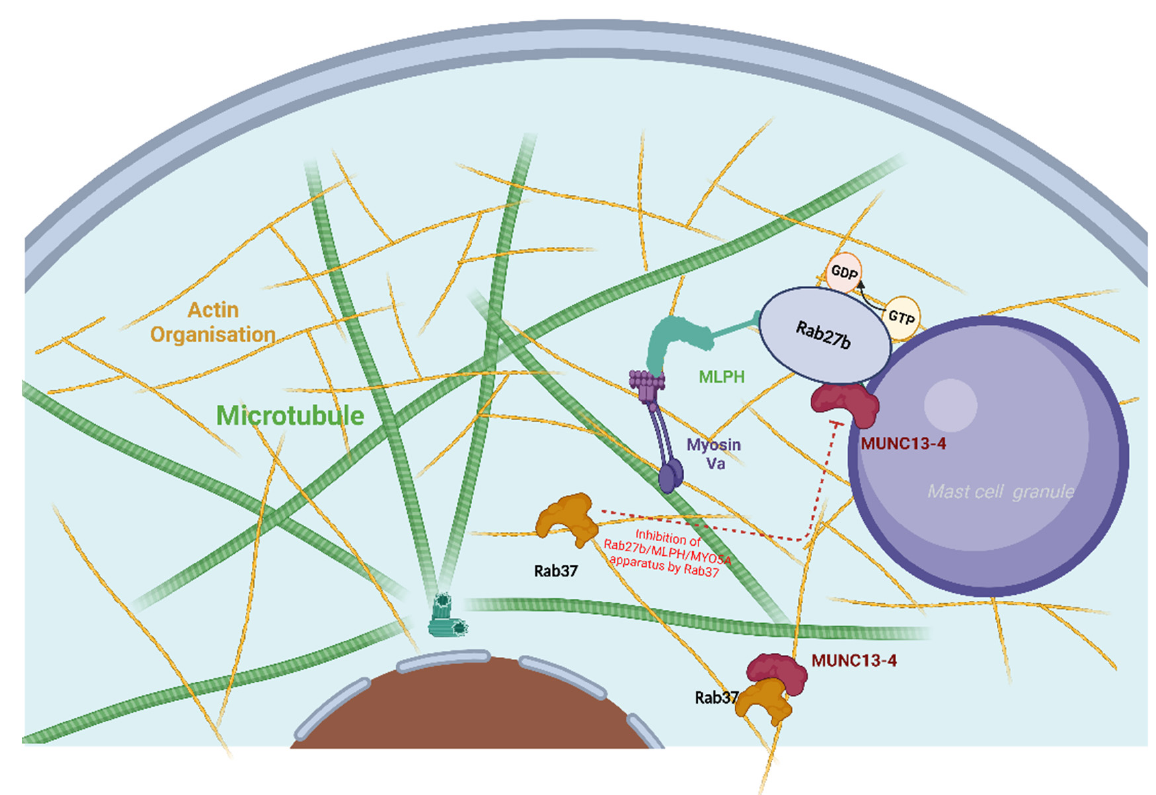
Figure 5. The granule transport machinery of MCs with involvement of melanophilin and Rab proteins. The intracellular transport of cytoplasmic granules to the MC surface for exocytosis requires a complex motor apparatus connected to the granule membrane, in which a motor protein myosin Va and microtubules work together. In this machinery, melanophilin (MLPH) directly connects myosin Va with Rab proteins located on the granule membrane. Subsequent docking to the plasma membrane is carried out by the protein unc-13 homolog D, which in turn can be blocked by RAB37. See main text for further details. Abbreviations: MLPH (melanophilin), MUNC13-4 (Protein unc-13 homolog D), RAB27A (Ras-related protein Rab-27A), RAB27B (Ras-related protein Rab-27B), and RAB37 (Ras-related protein Rab37).